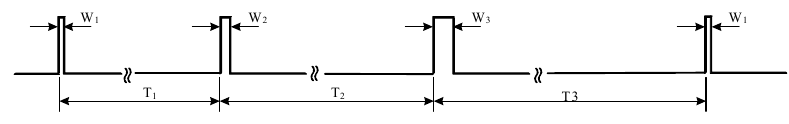
Figure 1. The basic waveform of the transmitted